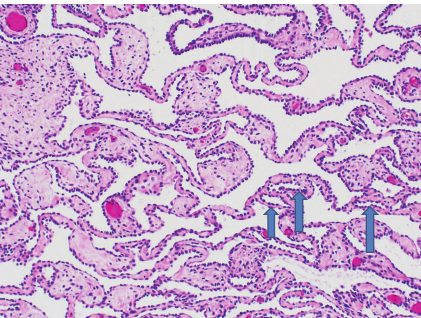
Figure 1: Gross image of right ovarian solid and multicystic mass which measured 27.0 × 17.0 × 5.0 cm. The capsular surface showed a 4.0 × 2.0 cm area of disruption (blue arrow). A 4.3 × 3.0 × 0.6cm solid area was also noted (red arrow).